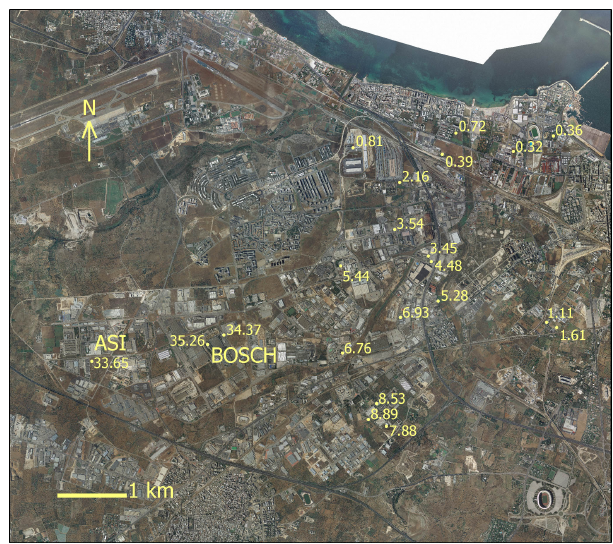
Figure 6. Measured piezometric heads (m, slm) from the February 2012 monitoring campaign.